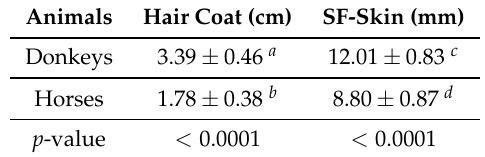
Table 1. Measured features (mean ± SD) of horses ( H.1 – H.16 ) and donkeys ( D.1 – D.16 ): the length of the hair coat and the thickness of the subcutaneous fat plus skin (SF-Skin).